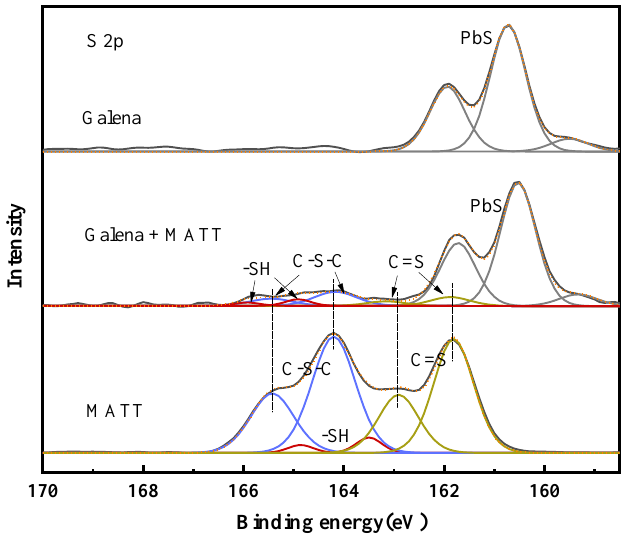
Figure 10. S 2p spectra of galena, galena treated with MATT, and MATT.